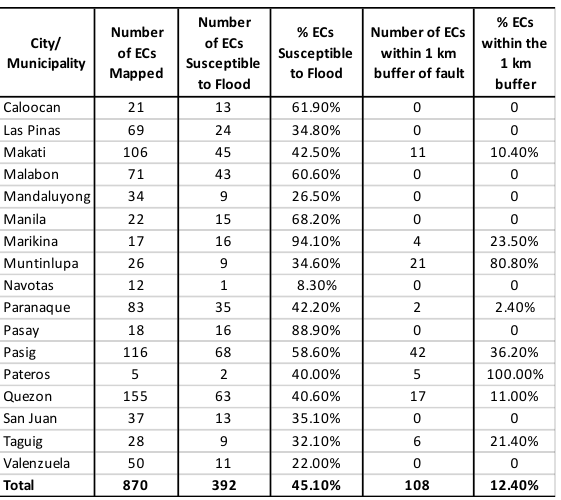
Figure 4. The 100-year return flood hazard map of Metro Manila (Data from LiPAD - LiDAR Portal for Archiving and Distribution). Table 3. Evacuation centers situated within the flood-prone areas and in the 1 km buffer of the West Valley Fault